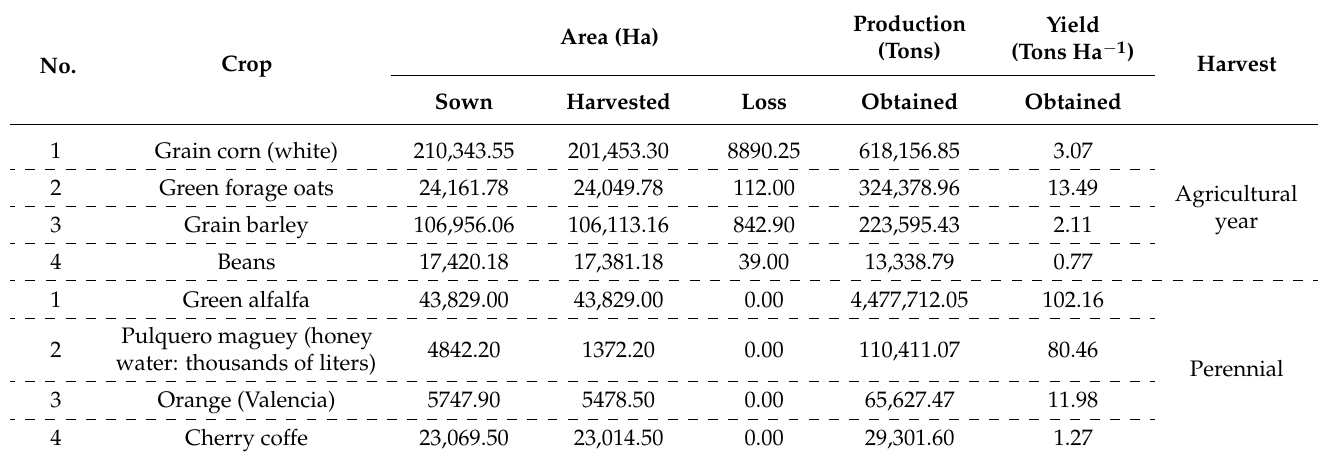
Table 1. Main crops and their production in 2021, in the State of